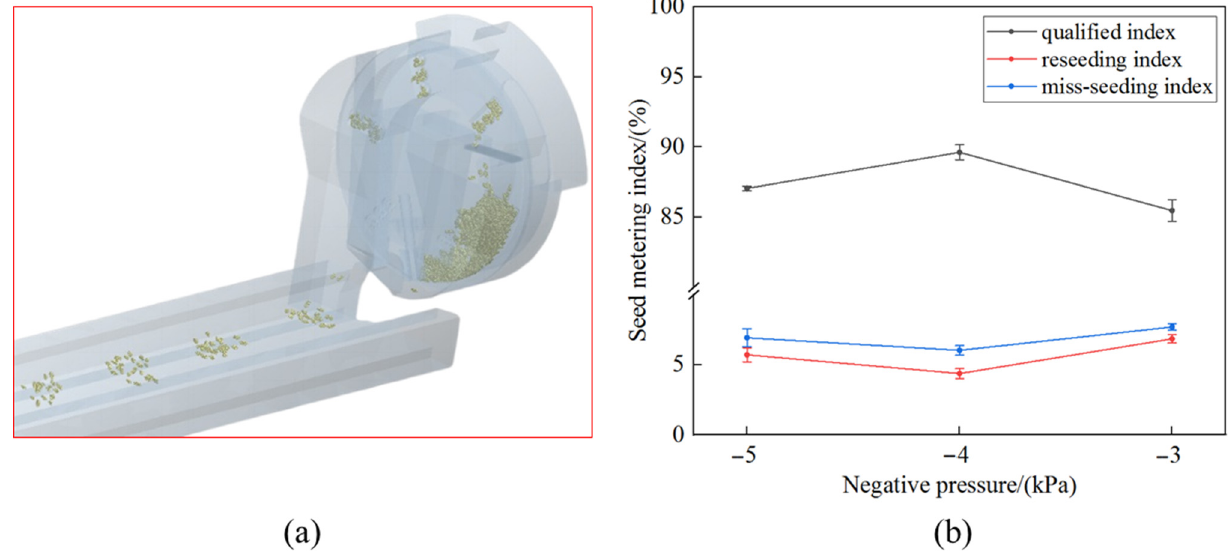
Figure 6. seed metering performance of CFD-DEM coupling simulation: ( a ) seed metering process of CFD-DEM coupling simulation; ( b ) seed metering results of CFD-DEM coupling simulation.